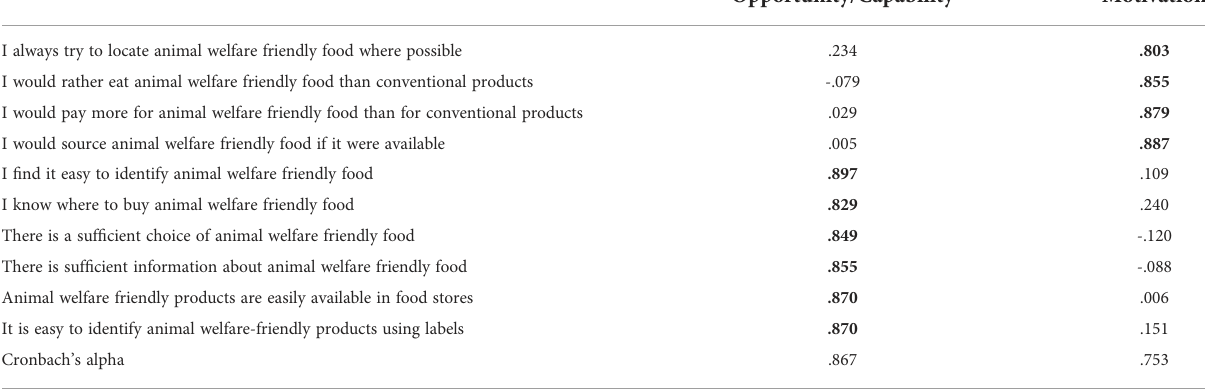
TABLE 3 Varimax rotated component loadings from a two-dimensional CATPCA*.